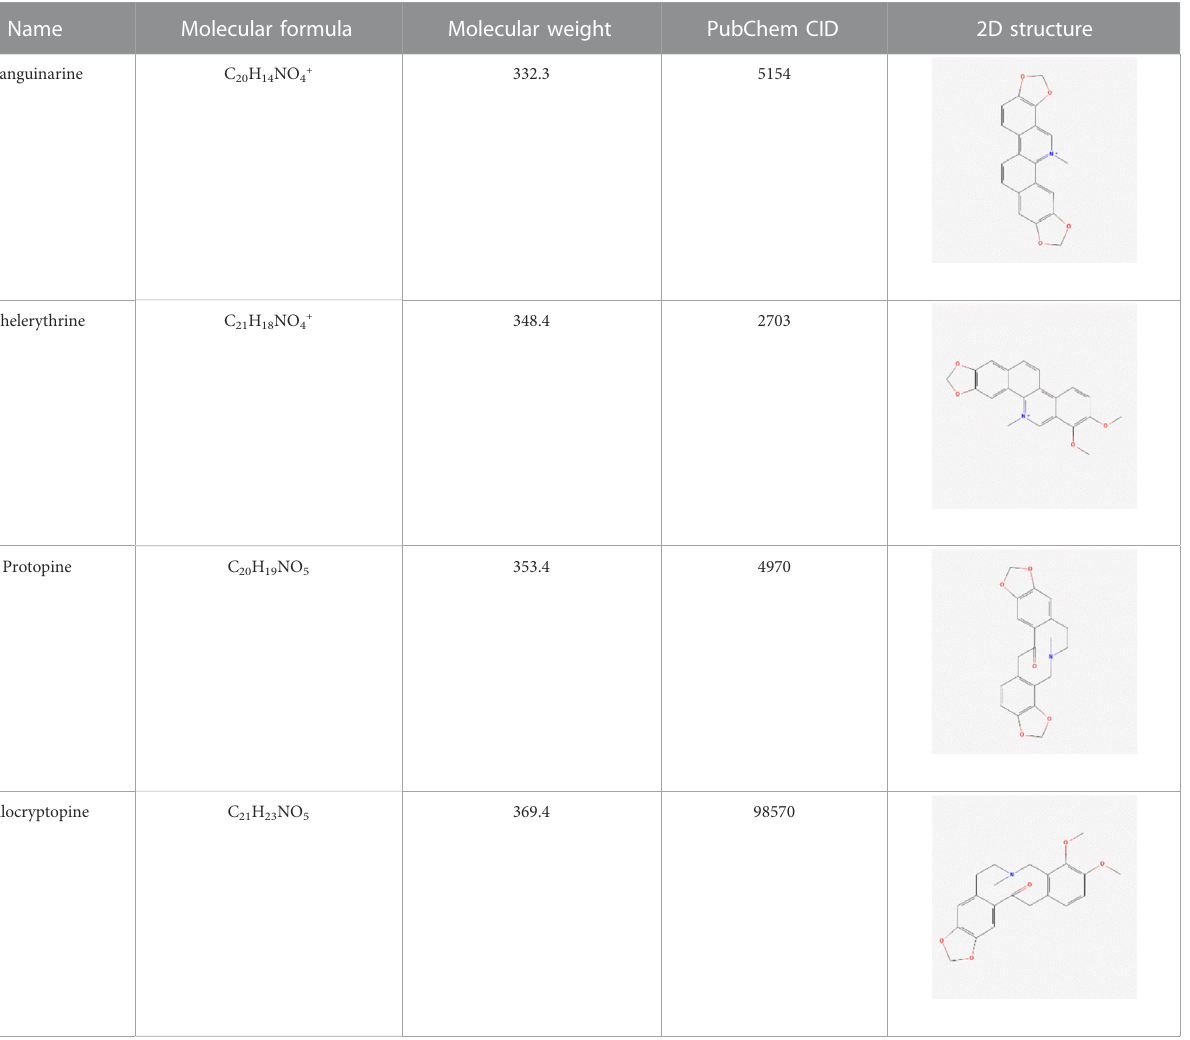
TABLE 1 Information on the active compounds of Macleaya cordata extract (MCE). Name Molecular